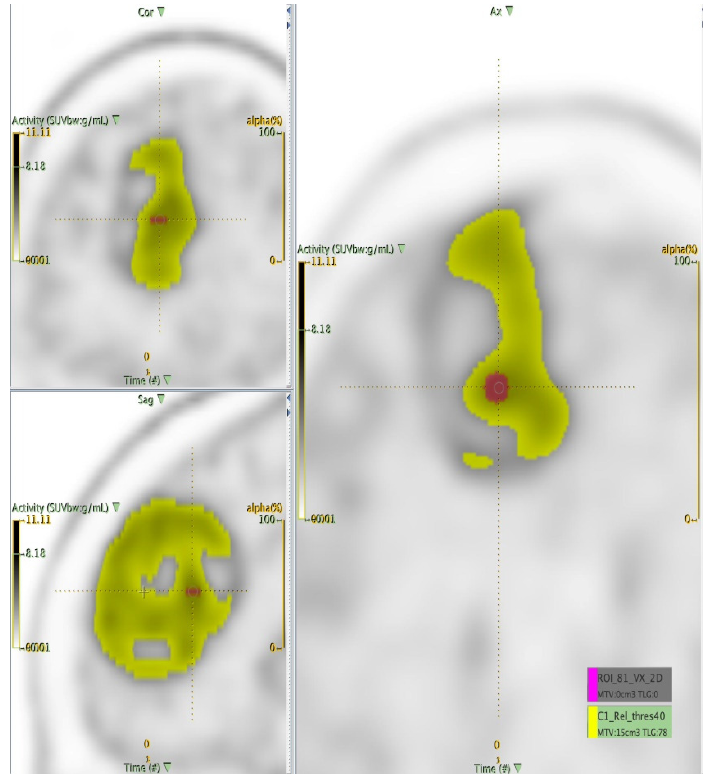
Figure 3. Illustration of volume segmentation (fixed ROI in purple vs. VOI in yellow).